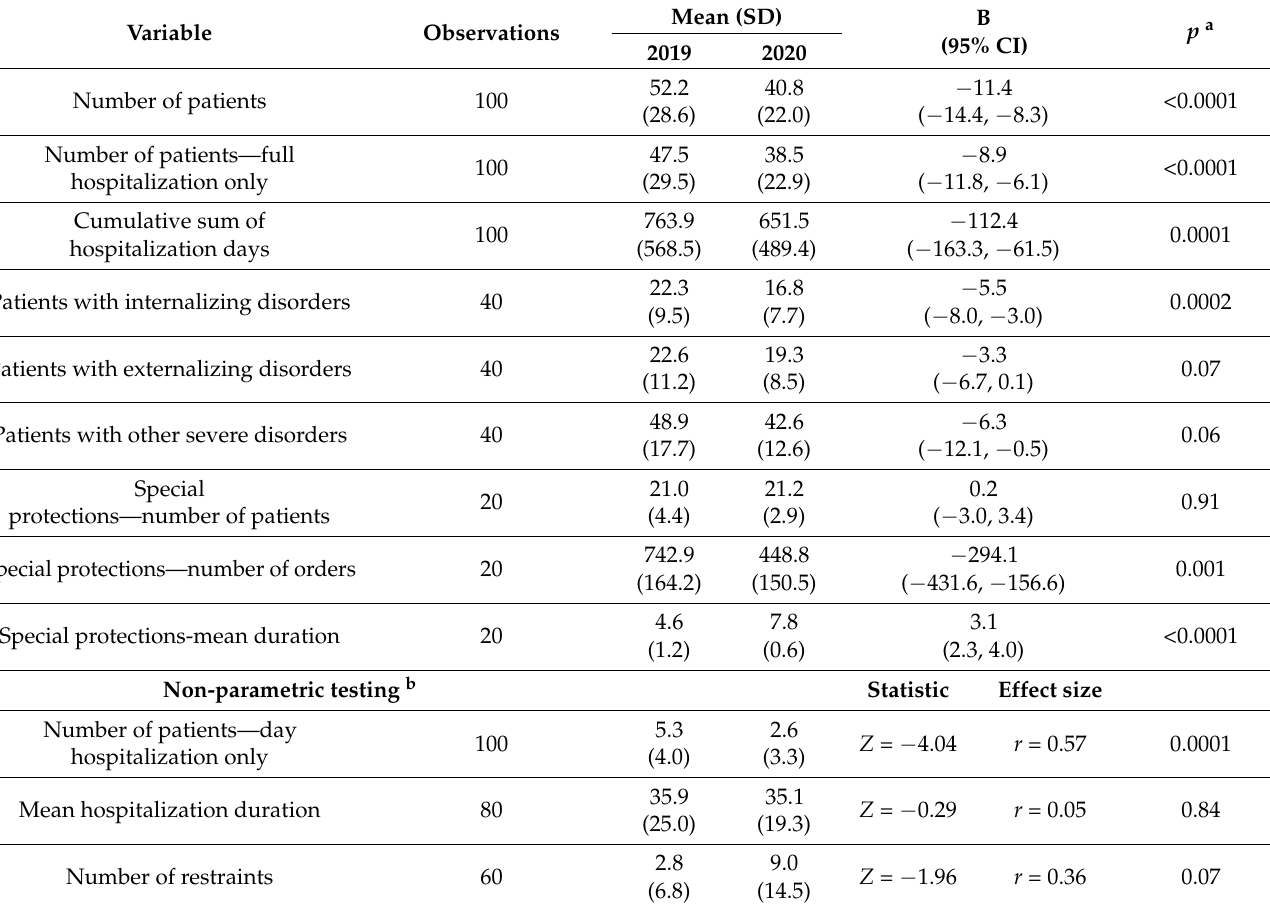
Table 1. Comparison of main characteristics in psychiatric hospitalization of youth between 2019 and